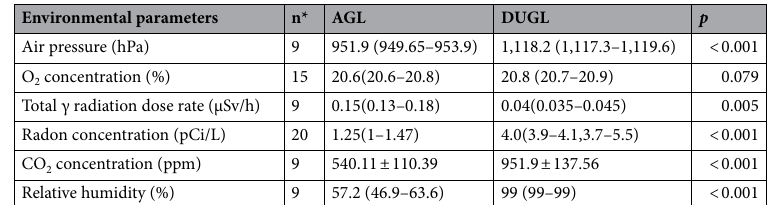
Table 1. Environmental characteristics in the DUGL and AGL. DUGL deep-underground laboratories, AGL above-ground laboratory. Data are expressed as mean ± SD or median (interquartile range). *Number of observations; each observation was made on a different day.